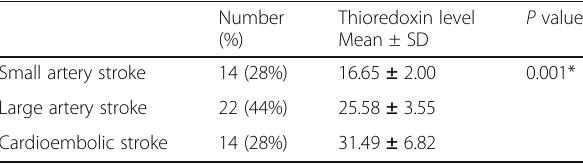
Table 4 Comparison between different acute ischemic stroke subtypes regarding the mean thioredoxin level P value Number Thioredoxin level (%) Mean ± SD Small artery stroke 14 (28%) 16.65 ± 2.00 0.001* Large artery